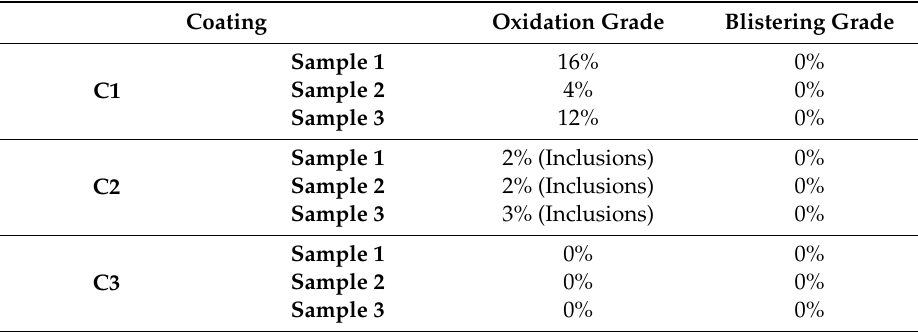
Figure 11. Visual appearance of the coatings’ surfaces after 720 h of exposure to combined aging according to the ISO 12944-9 and NORSOK M-501 standards. Table 7. Summary of the oxidation and blistering grade of the coatings after the combined aging test in accordance with the ISO 12944-9 [18] and NORSOK M-501 [16]